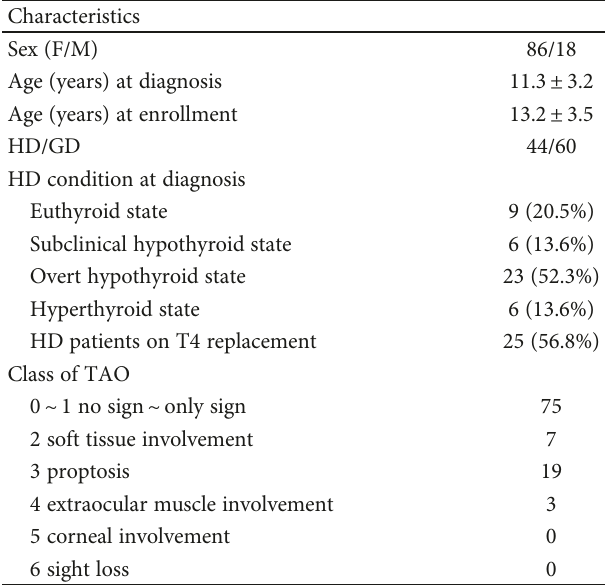
Table 1: Characteristics of 104 autoimmune thyroid disease